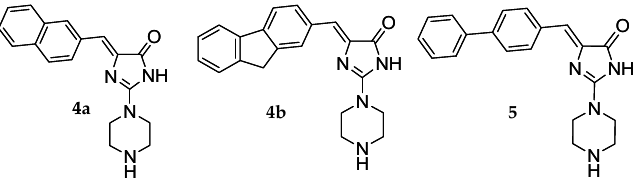
Figure 2. Active 5-arylideneimidazolones ( 4a , 4b , 5 ) found previously.